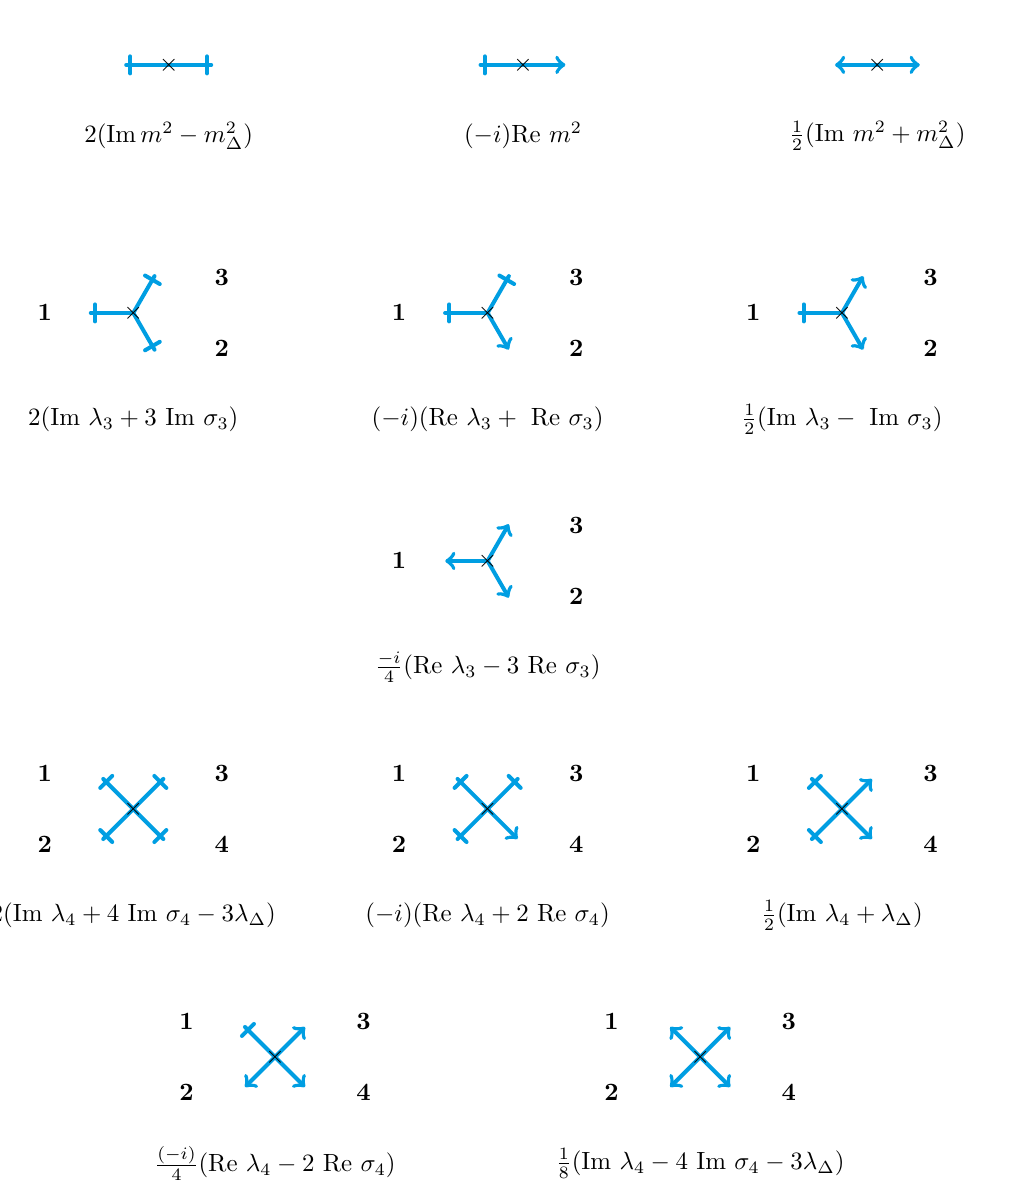
Figure 33. Feynman rules in the average-di(cid:11)erence